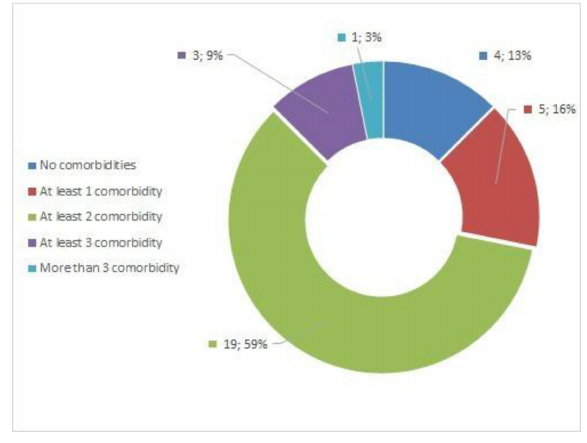
Figure 4. Presence of